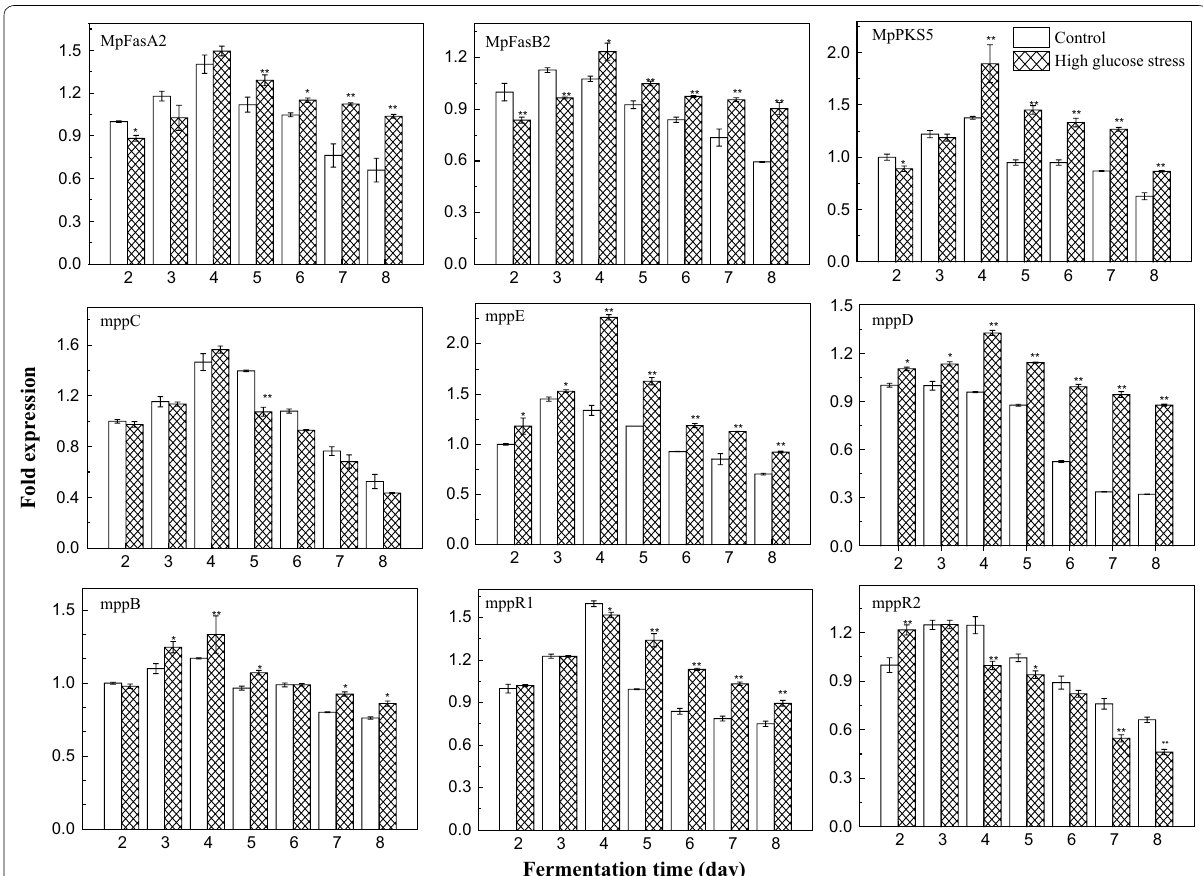
Fig. 4 Relative expression levels of the pigment biosynthesis related genes MpFasA2, MpFasB2, MpPKS5, mppB, mppC, mppD, mppE, mppR1 and mppR2 as monitored by qRT-PCR. Error bars represent the standard deviation (n